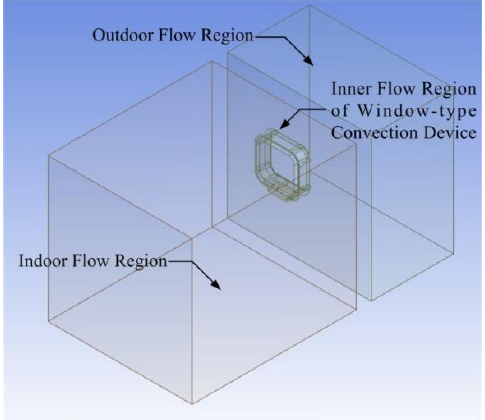
Figure 6. Geometric model for flow-field analysis, which comprises the outdoor flow region, the indoor flow region, and the inner flow region of the window-type convection device.